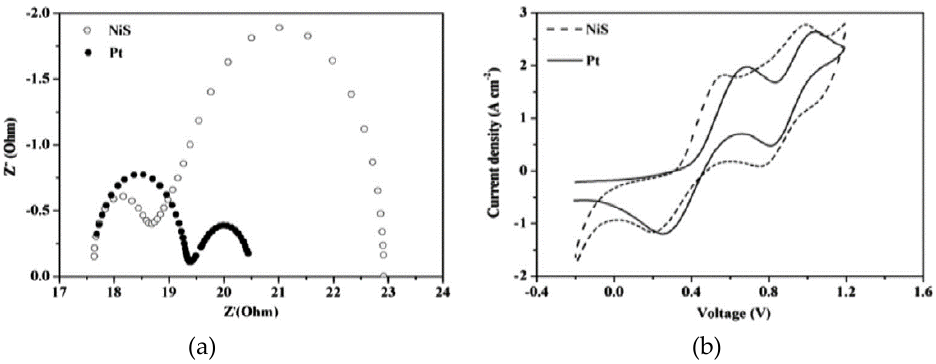
Figure 2. ( a ) Electrochemical Impedance Spectroscopy (EIS) and ( b ) Cyclic Voltammetry (CV) analysis for NiS and Pt counter electrodes. Reproduced with permission from Reference [22], Elsevier 2016.